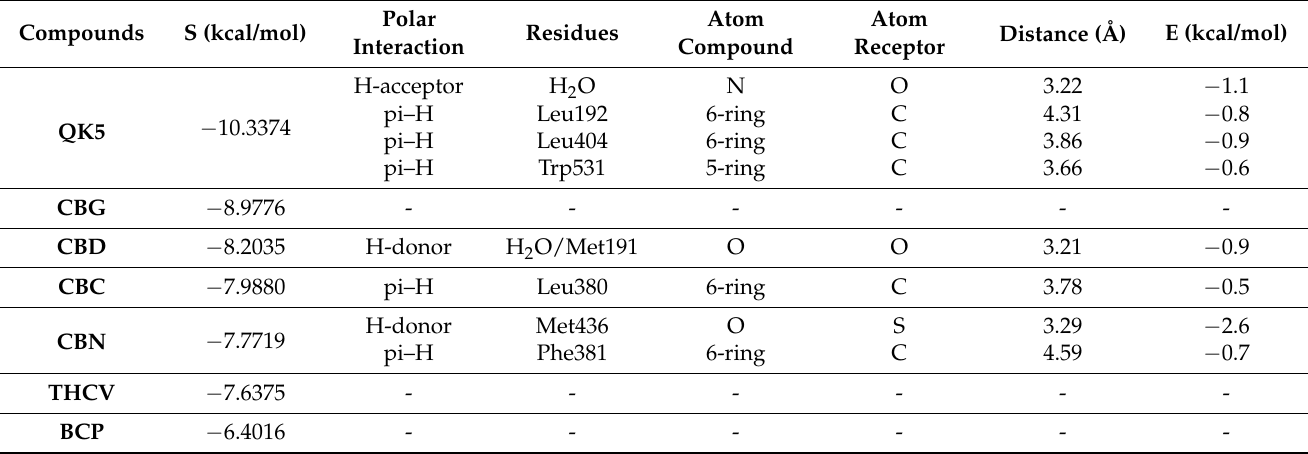
Table 1. Docking results of QK5 and cannabinoid-derived compounds on rFAAH.